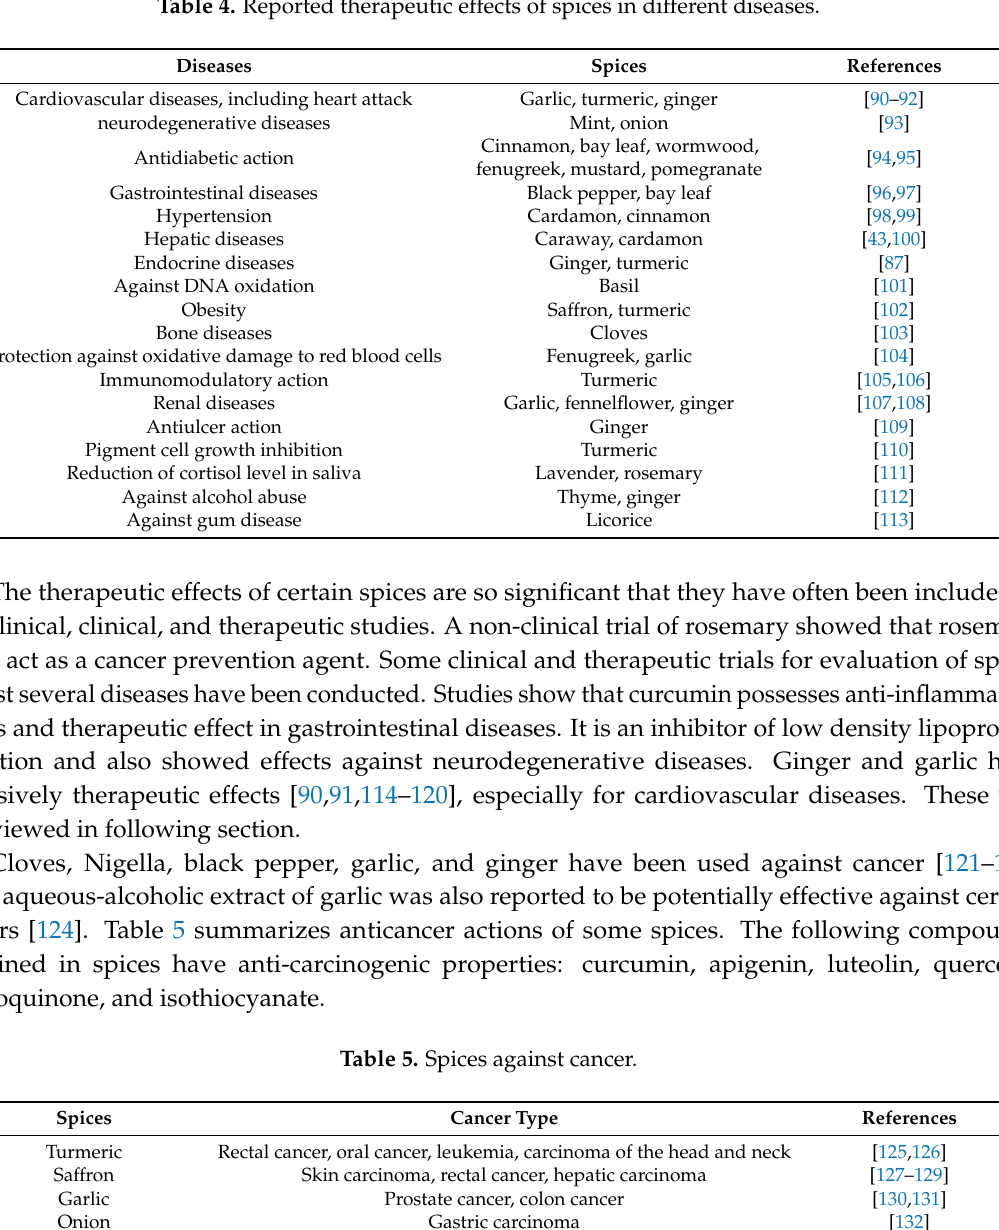
Table 4. Reported therapeutic effects of spices in different diseases.